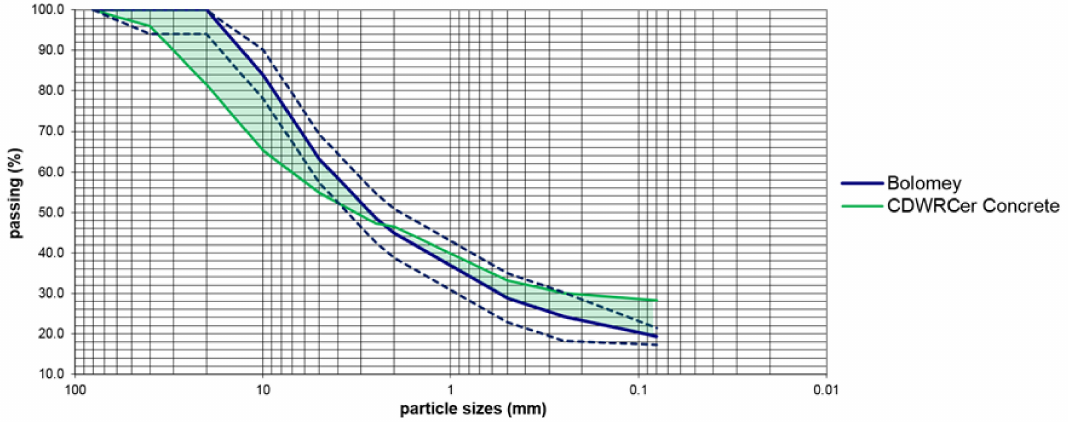
Figure 3. CDWRCer versus Bolomey granulometric curves.